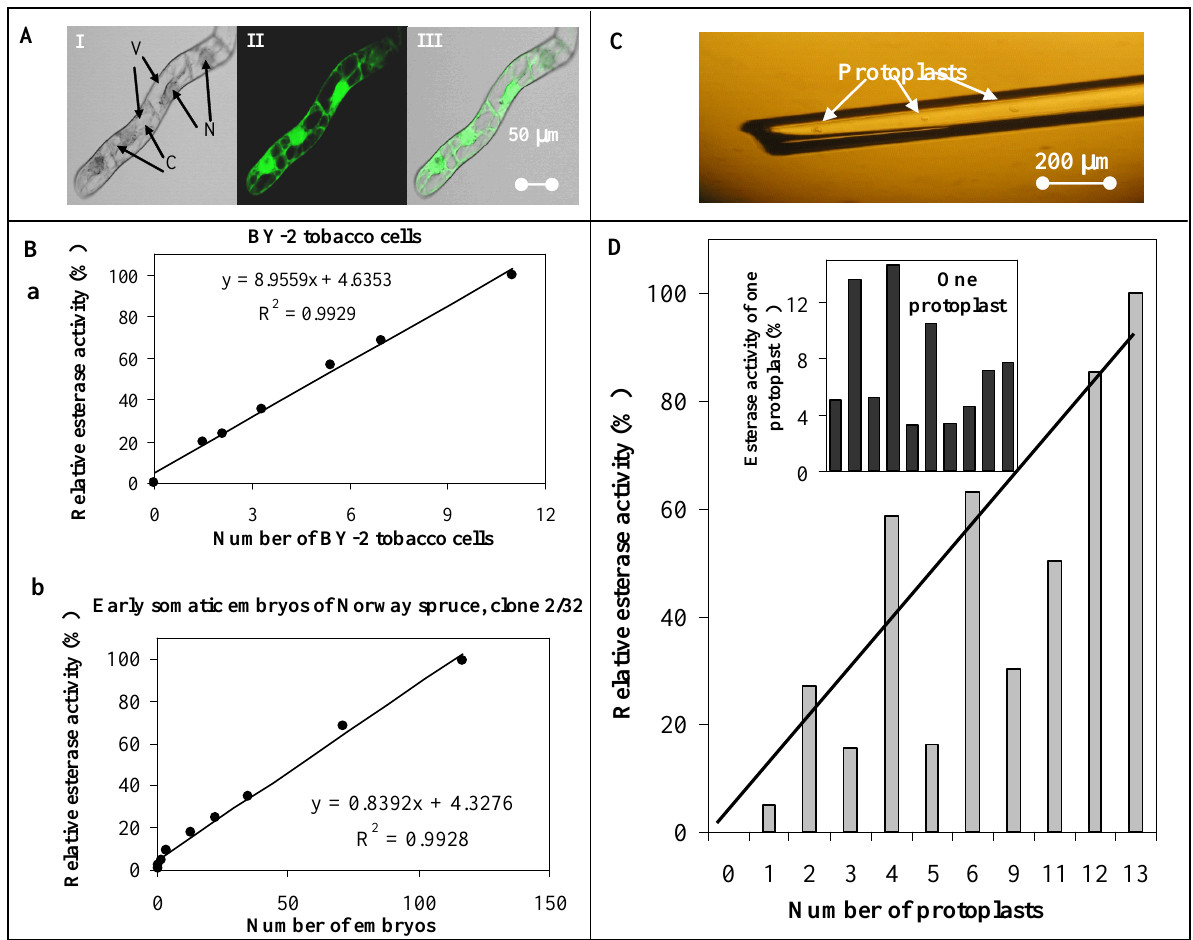
Figure 5. Single cell analysis. Confocal images of BY-2 tobacco cells in bright field ( A ). Arrows indicate cytoplasmic strands (C), vacuoles (V), and nuclei (N) (I). Confocal image in the fluorescein channel reveals esterase activity (II). Merged confocal image shows colocalisation of esterase activity with nuclei and cytoplasmic strands (III). Dependence of number of BY-2 tobacco cells ( a ) and number of early somatic embryos ( b ) on their esterase activity ( B ). Photography of glass capillary containing harvested protoplasts ( C ). Relative esterase activity of different number of protoplasts ( D ). Inset in ( D ): diversity of esterase activity per one protoplast. Relative esterase activity of 5.7 · 10 -7 IU (Ba) and 1.8 · 10 -7 IU (Bb) and 8.2 · 10 -7 IU (D) corresponds to the 100 %. Except for the esterase assay